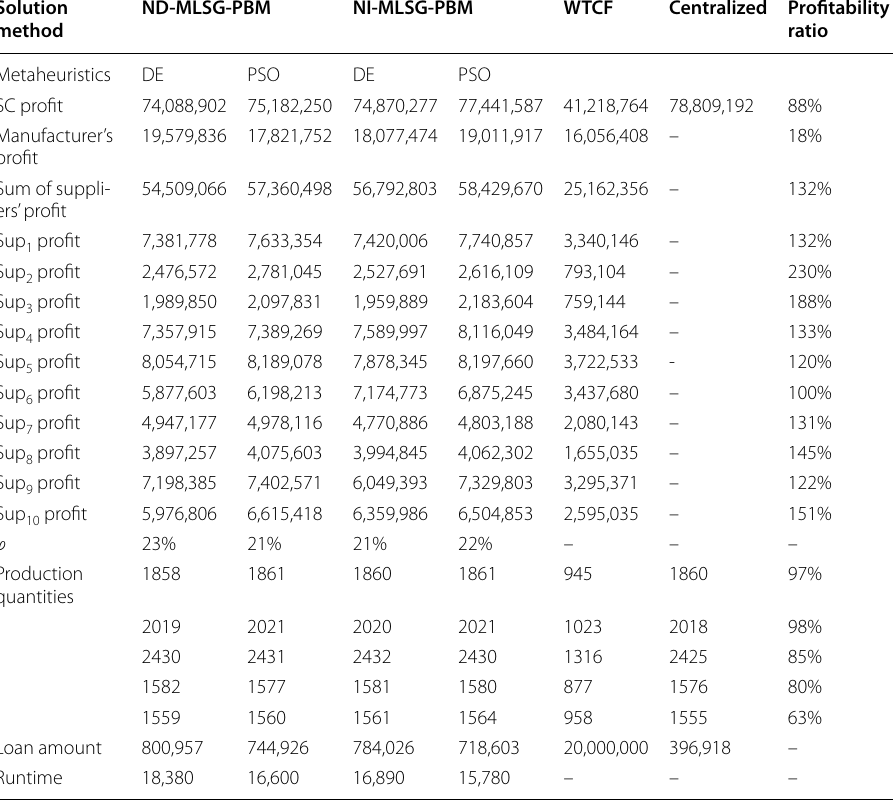
Table 6 A summary of the results for the TCFRS contract, WTCF case, and the centralized model for the test problems in size